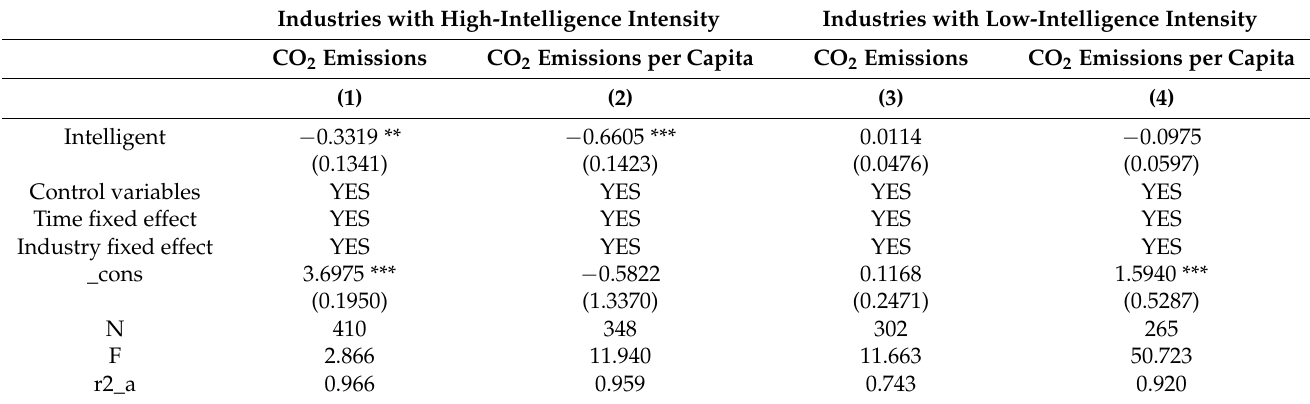
Table 5. The impact of intelligent manufacturing on carbon emissions under the intelligence